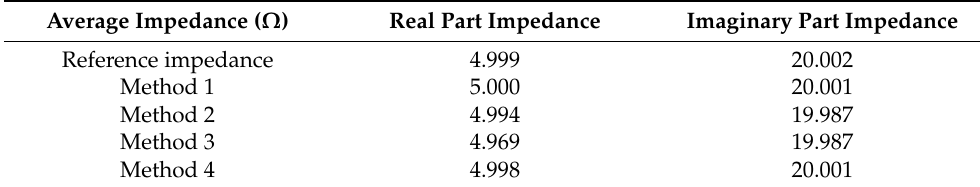
Figure 13. The error of simulation II. ( a ) Impedance real part error; ( b ) Impedance imaginary part error. Table 3. Average